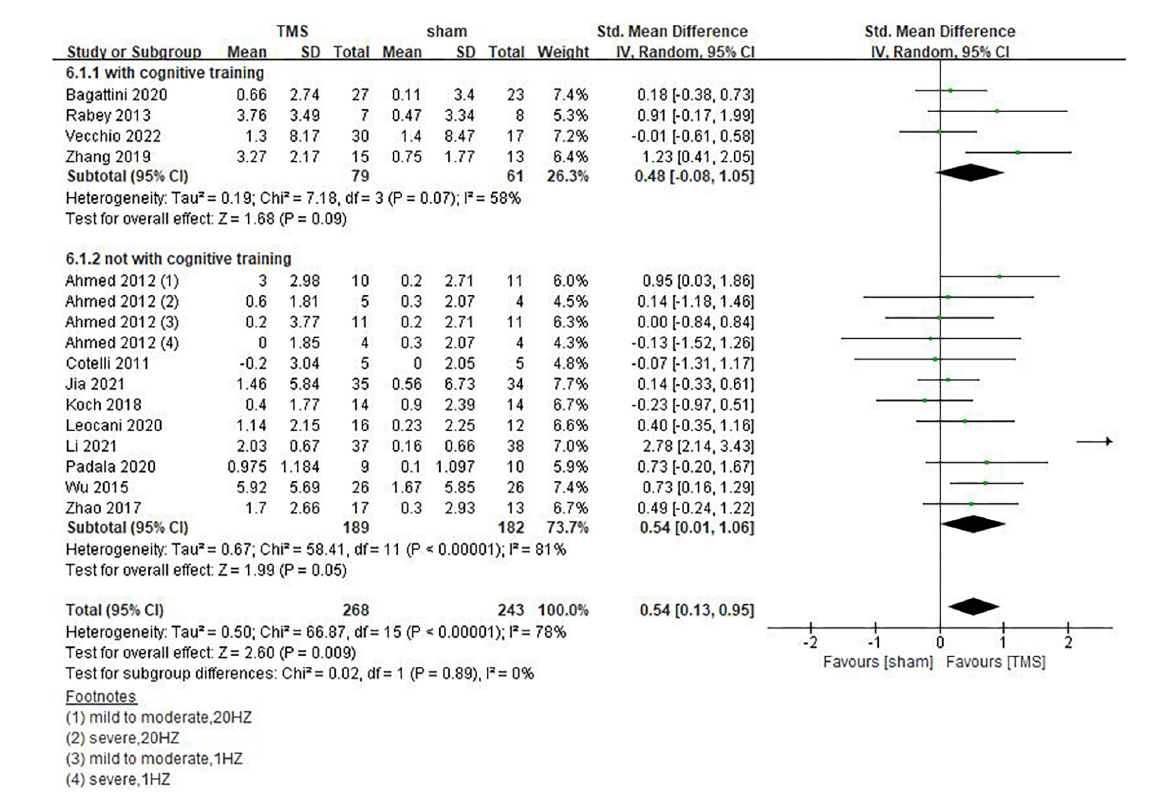
FIGURE7 Influence of repetitive transcranial magnetic stimulation (rTMS) combined cognitive training on global cognitive